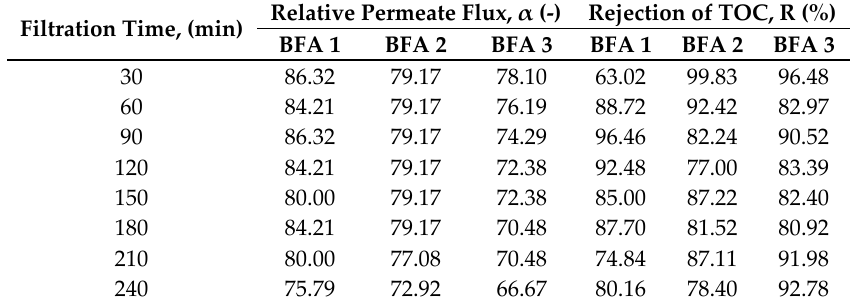
Table 4. Values of parameters related to transport and separation properties of nanofiltration (NF) membranes. Filtration Time,